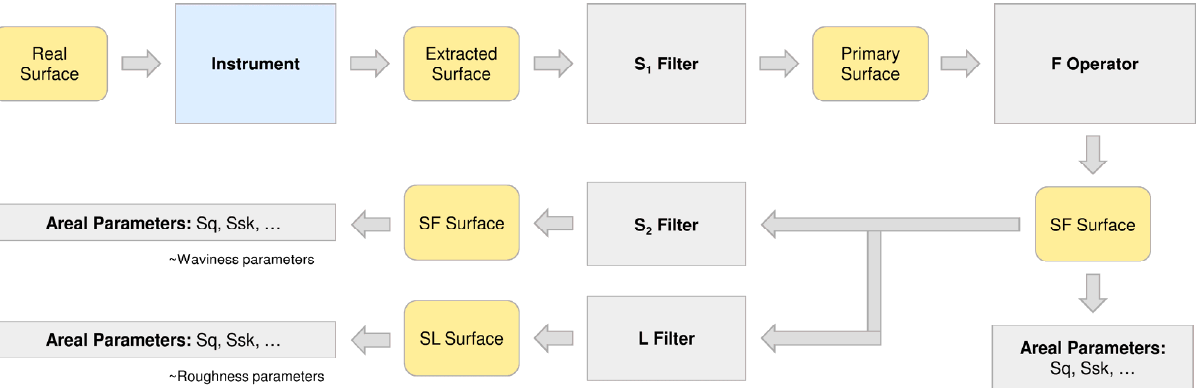
Figure 10. Typical procedure for areal parameters determination (courtesy of François Blateyron, Digital Surf [52]).